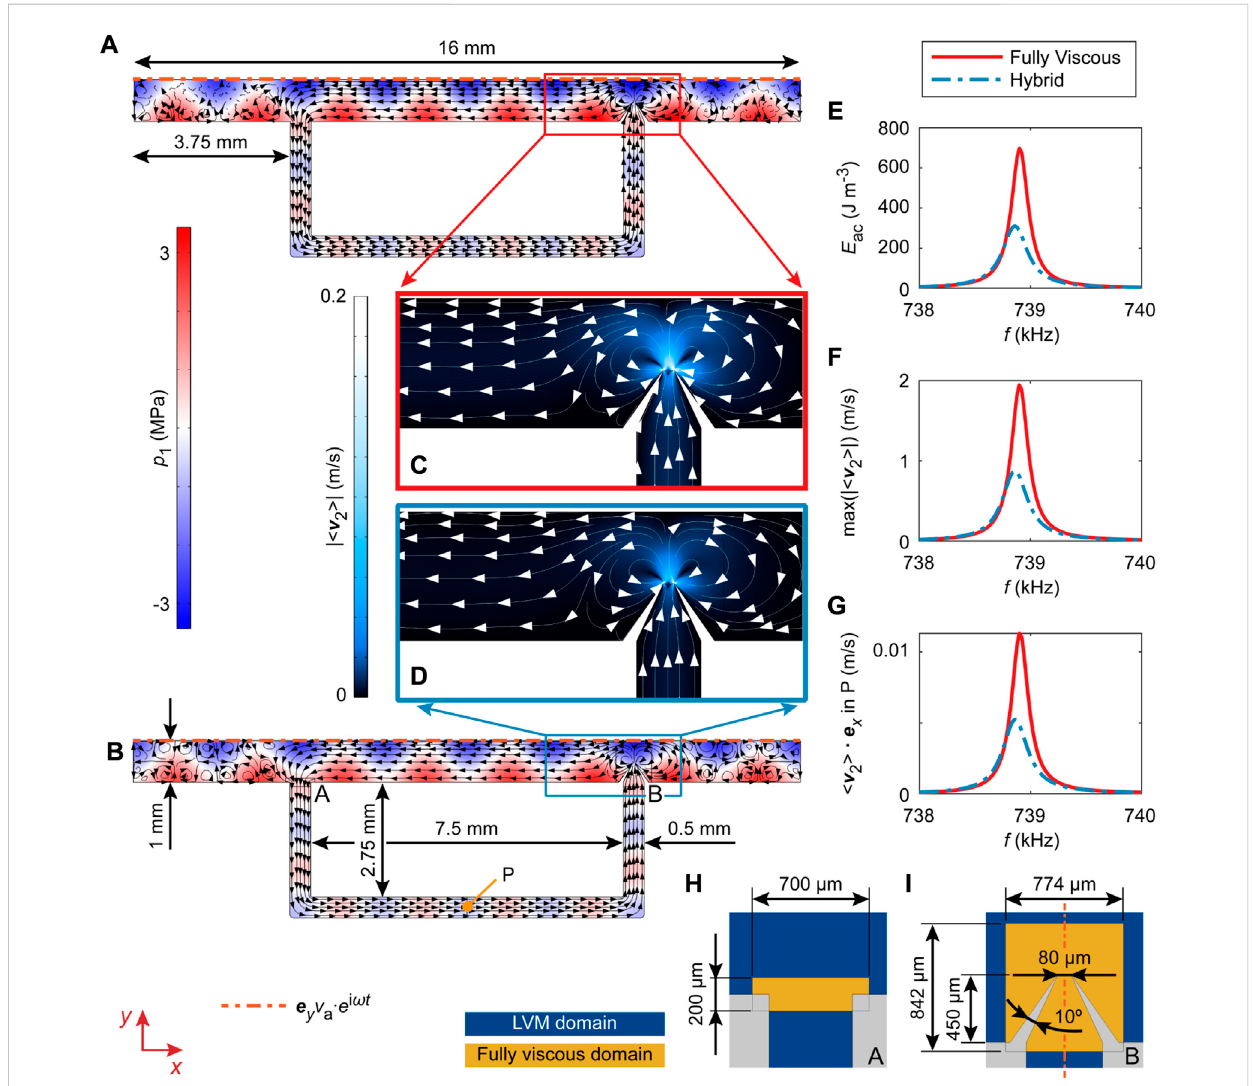
FIGURE 8 Different modeling approaches validated on a complex 2D geometry containing a pair of sharp edges that can facilitate pumping. The geometry is inspired by the experimental device from [9]. We compare the performance of the Fully Viscous model and the Hybrid model that combines the Fully Viscous domain with the limiting velocity method domain. The comparison is made for one of the resonance modes in water with the dimensions of the rigid channels de fi ned in (A) , (B) , (H ), and (I) , where (H) and (I) show the Fully Viscous domains. The acoustic pressure and the streamlines of the Eulerian streaming velocity are shown in (A) for the Fully Viscous model and in (B) for the Hybrid model and (C) and (D) show the respective zoomed-in Eulerian streaming fi elds near the pair of sharp edges. The compared fi elds correspond to f = 738.85 kHz, where (E) shows the average acoustic energy density E ac , (F) shows the maximal Eulerian streaming velocity magnitude | 〈 v 2 〉 |, and (G) shows the x -component of the Eulerian streaming velocity in point P, de fi ned in (B) . The excitation in a form of an oscillatory velocity in the y -direction with an amplitude v a = 1 mm s − 1 is imposed on the whole uppermost